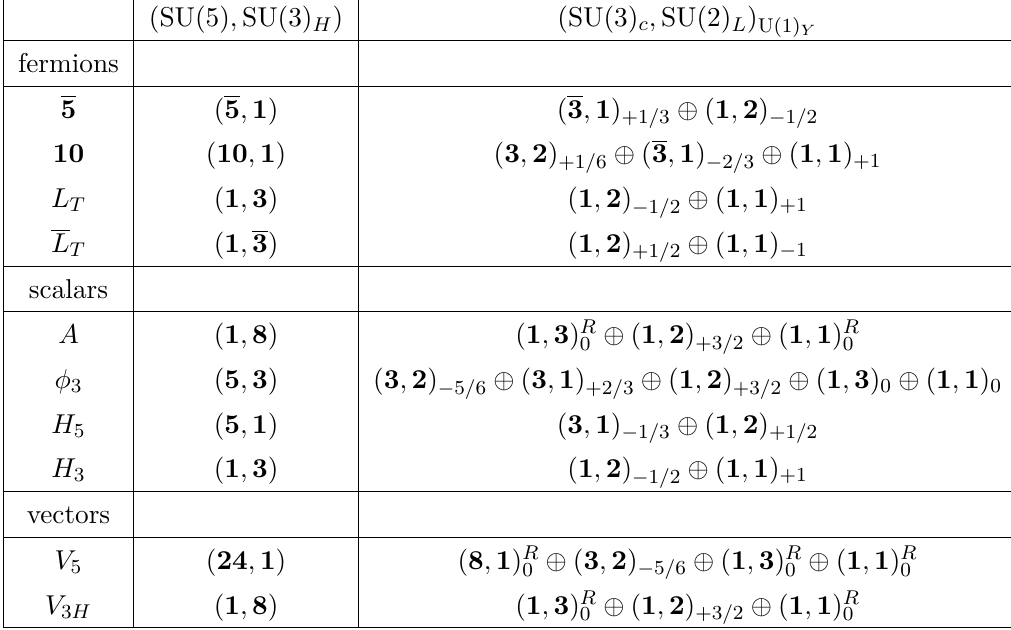
. Each fermion U(1) Y